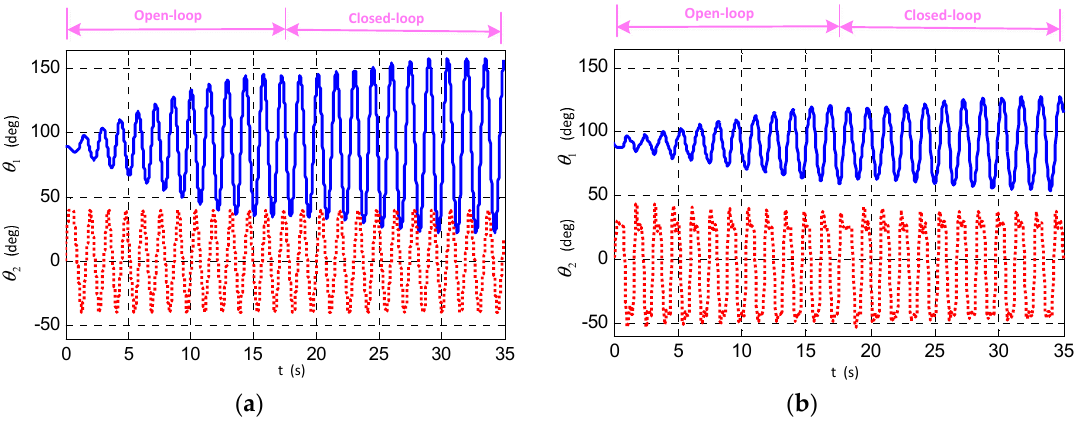
Figure 10. Snapshots of the robot (left) and the two-link model (right) starting from the at rest condition. The robot/model uses the open-loop control method ( a – d ) and then the closed-loop control method ( e , f ).